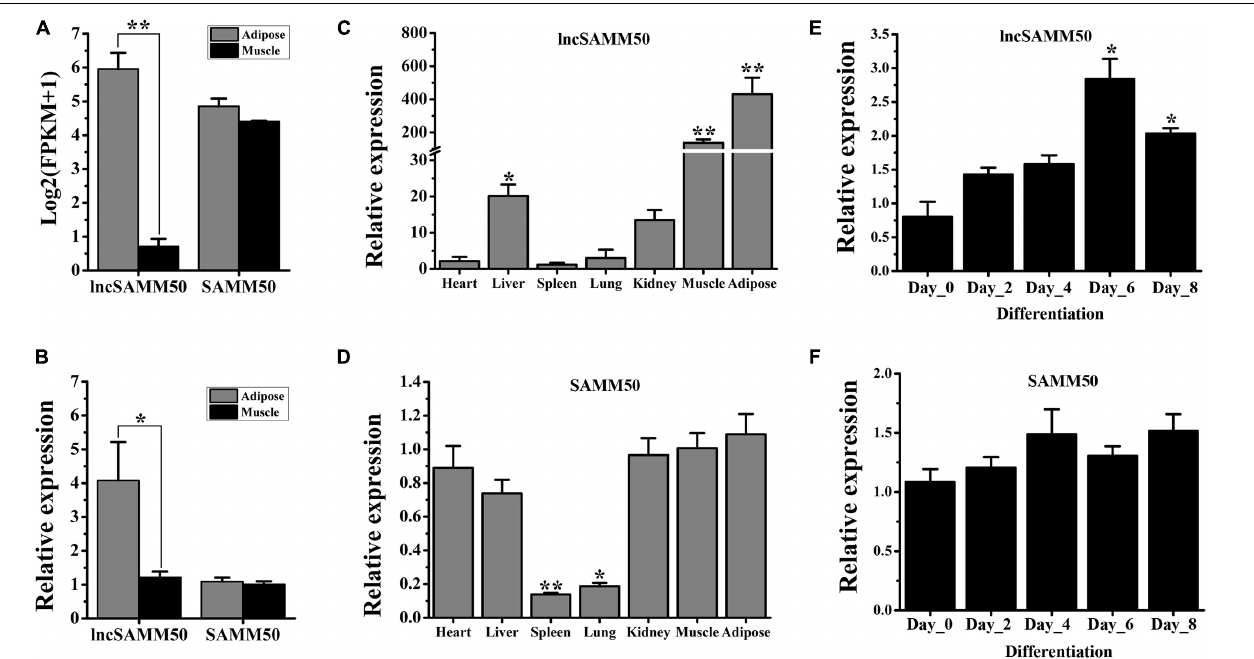
FIGURE 3 | Expression pattern of lncSAMM50 and SAMM50 in buffalo. (A) The expression pattern of lncSAMM50 and SAMM50 in adipose and muscle tissues by RNA sequencing. (B) The expression pattern of lncSAMM50 and SAMM50 in adipose and muscle tissues by qRT-PCR. (C) The expression profile of lncSAMM50 in heart, liver, spleen, lung, kidney, muscle, and adipose tissues. (D) The expression profile of SAMM50 in heart, liver, spleen, lung, kidney, muscle, and adipose tissues. For panels (A–D) , Xinyang buffalo (30 months of age, n = 3) was used; the UXT gene was used to normalize the expression level of the candidate gene. (E) The expression pattern of lncSAMM50 during adipocyte differentiation. (F) The expression pattern of SAMM50 during adipocyte differentiation. GAPDH was used to normalize the expression level of the candidate gene in adipocytes. The cycle threshold (2 − (cid:49)(cid:49) Ct ) method was used to calculate the relative expression level of the candidate gene. Data are presented as the mean ± SD ( n = 3; * p < 0.05; ** p < 0.01).